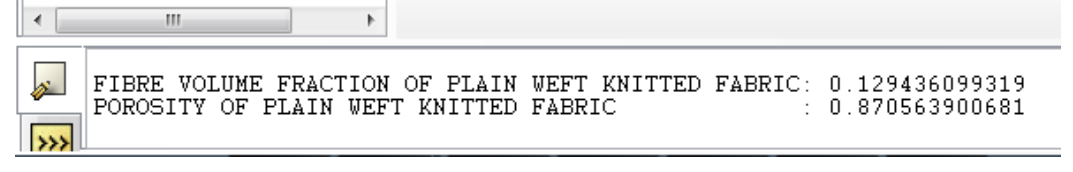
Figure 7. Printed results of porosity in message area of Abaqus/CAE.